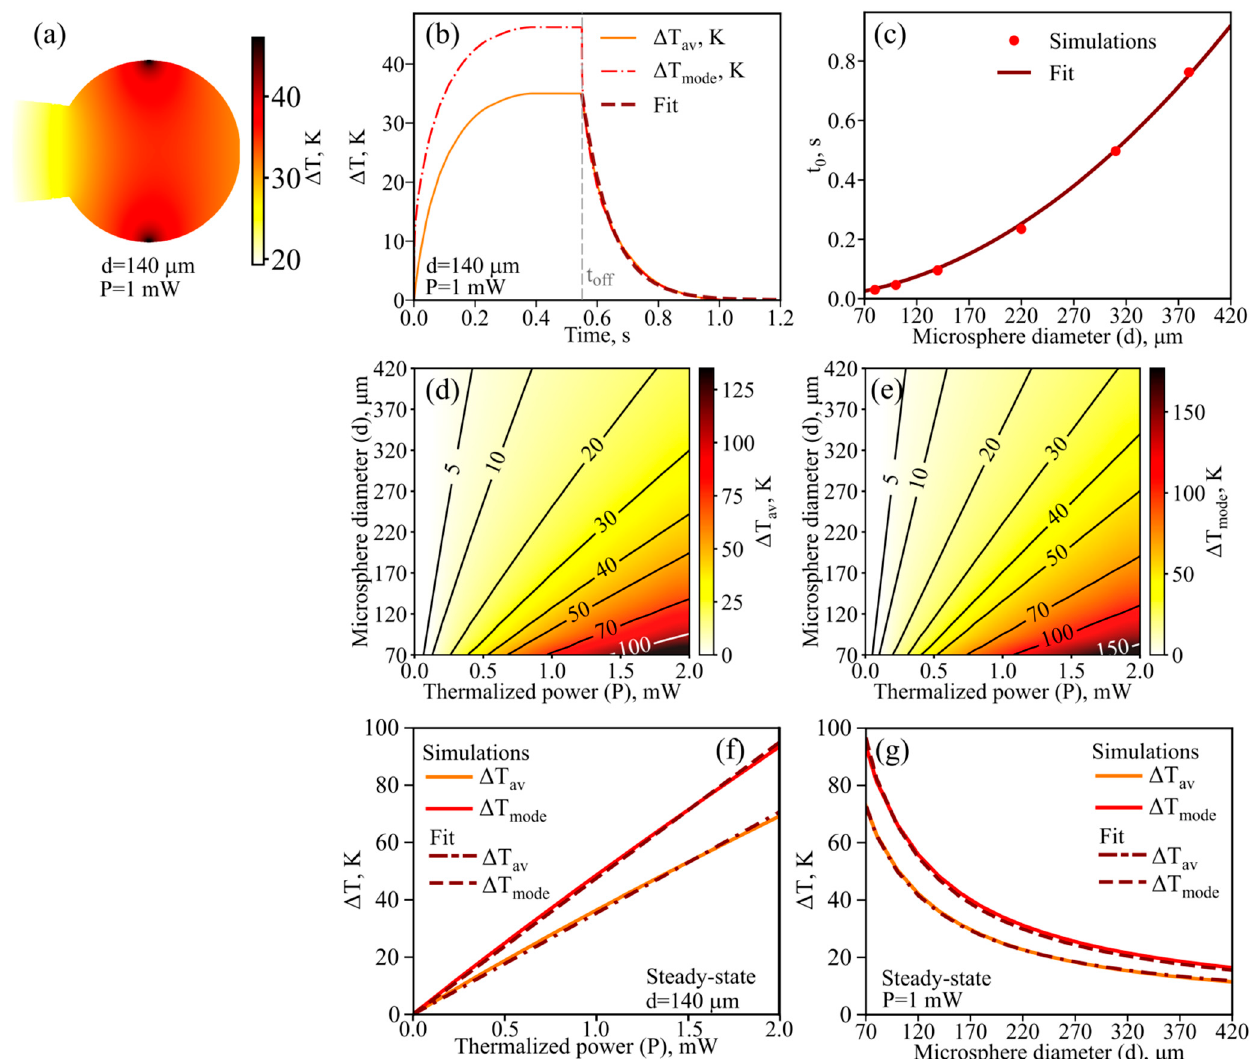
Figure 3. Numerical results. ( a ) Distribution of steady-state temperature increase in microresonator with diameter d = 140 µ m for thermalized power P = 1 mW. ( b ) Temporal dynamics of temperature increases averaged over fundamental mode ( ∆ T mode ) and over microsphere ( ∆ T av ) when pump is switched on with a thermalized power of 1 mW and switched off at the moment t off , marked by the vertical gray dashed line. ‘Fit’ is approximation of ∆ T av by exponential decay with characteristic time t 0 when pump is switched off. ( c ) Dependence of t 0 on microsphere diameter obtained by direct simulations and fitted by t 0 = C 1 · d 2 , where C 1 = 5.2 × 10 − 6 s · µ m − 2 . Steady-state temperature increase averaged over the microsphere ( d ) and over the fundamental mode ( e ) as functions of thermalized power and microsphere diameter. ( f ) Average temperature increases for d = 140 µ m and their linear fits ( ∆ T ~ P ). ( g ) Average temperature increases for P = 1 mW and their fits ( ∆ T ~1/ d ). As for the temperature averaged over the WGM region, its dynamics are more com- plex, and within the framework of our model, are not described by a single decaying exponential dependence on time. Namely, when the pump is switched off, ∆ T mode first rapidly decreases to a value of about ∆ T av ( t = t off ) in time << t 0 , and then both average values ∆ T av and ∆ T mode decrease exponentially with a characteristic time t 0 (Figure